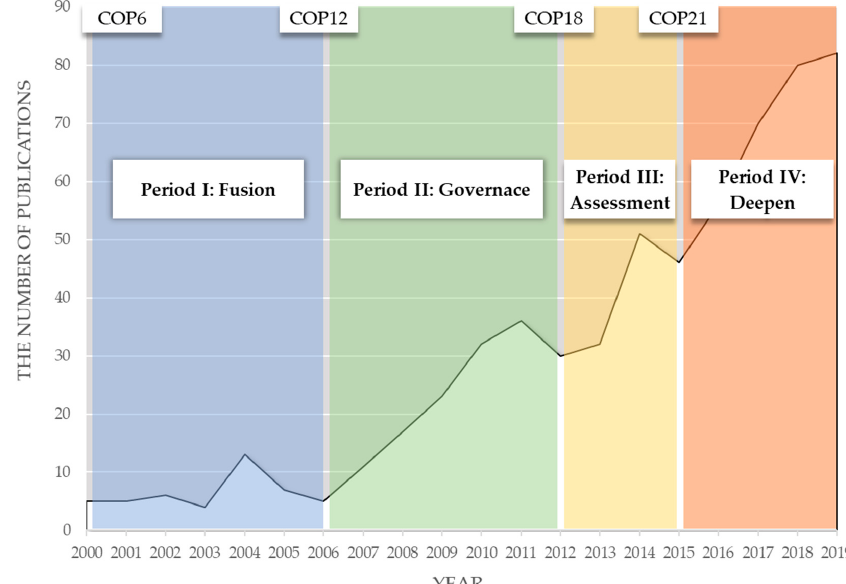
Figure 9. Temporal change in publications on climate change and environmental regulation.